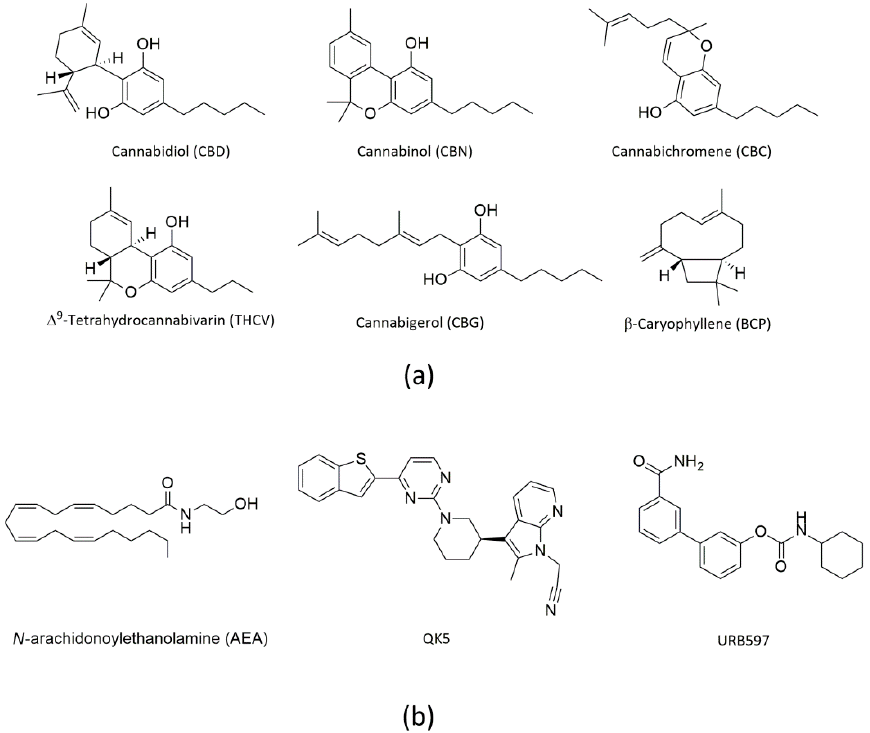
Figure 1. Chemical structures of ( a ) cannabis-derived compounds, and ( b ) AEA and two potent FAAH inhibitors, QK5 and URB597.